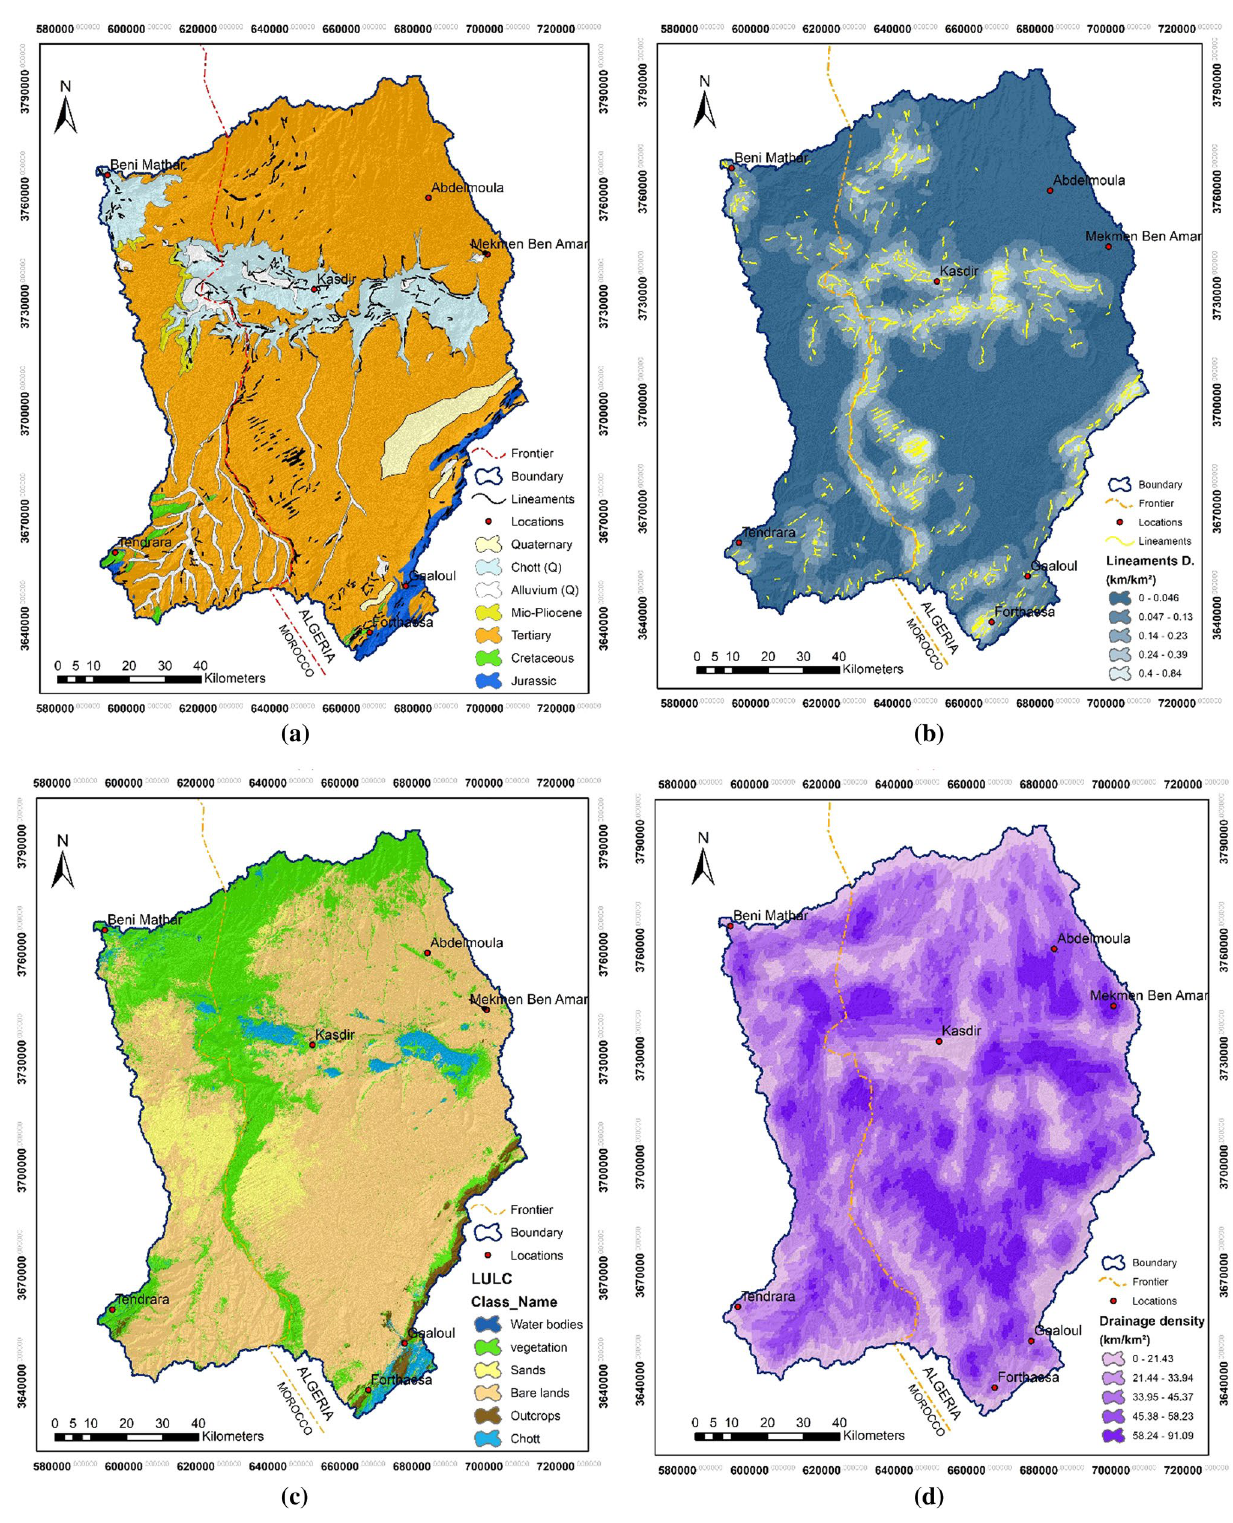
Fig. 3 Influencing factors maps: a Geology, b Lineaments density, c LULC, d Drainage density e Slope, f Elevation, g Rainfall, h water table